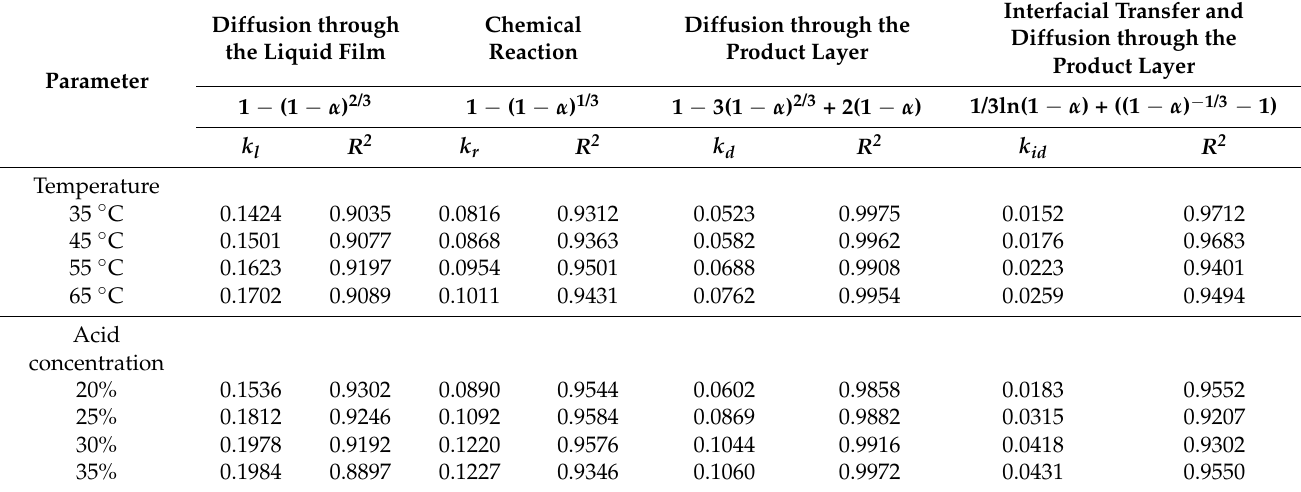
Table 4. Apparent rate constants for kinetics models and correlation coefficients at fast reaction stage. Interfacial Transfer Diffusion through Chemical Diffusion through the Reaction Product Layer Parameter